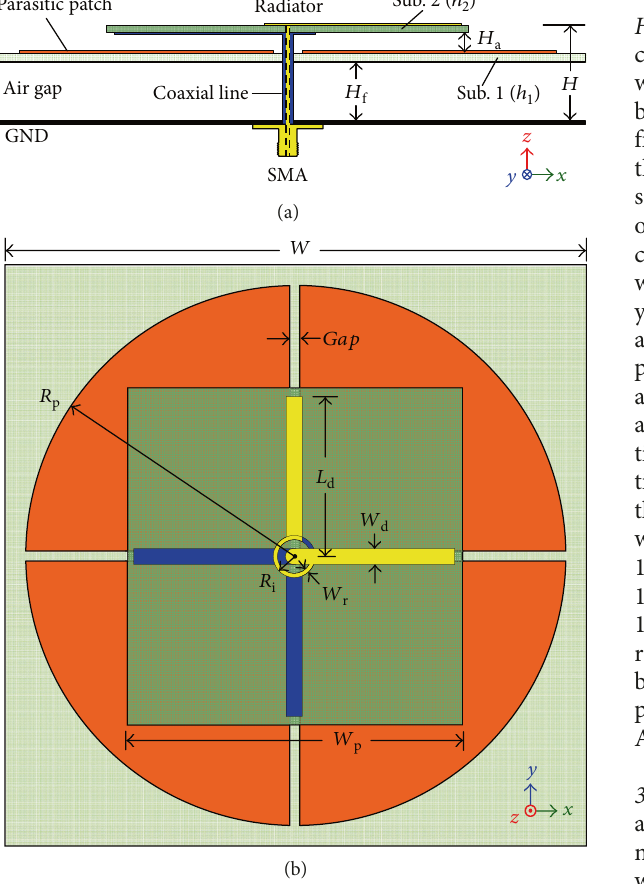
Figure 10: Geometry of the proposed antenna: (a) cross-sectional view and (b) top